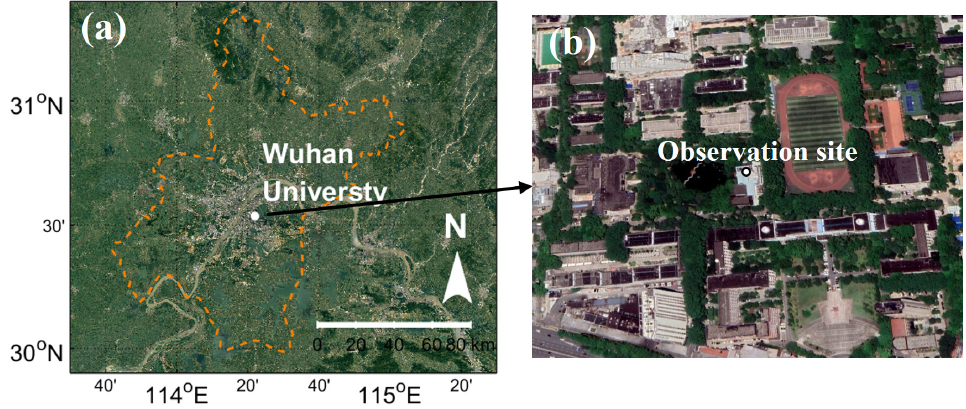
Figure 1. Study area of ( a ) Wuhan, Hubei Province; and ( b ) observation site.